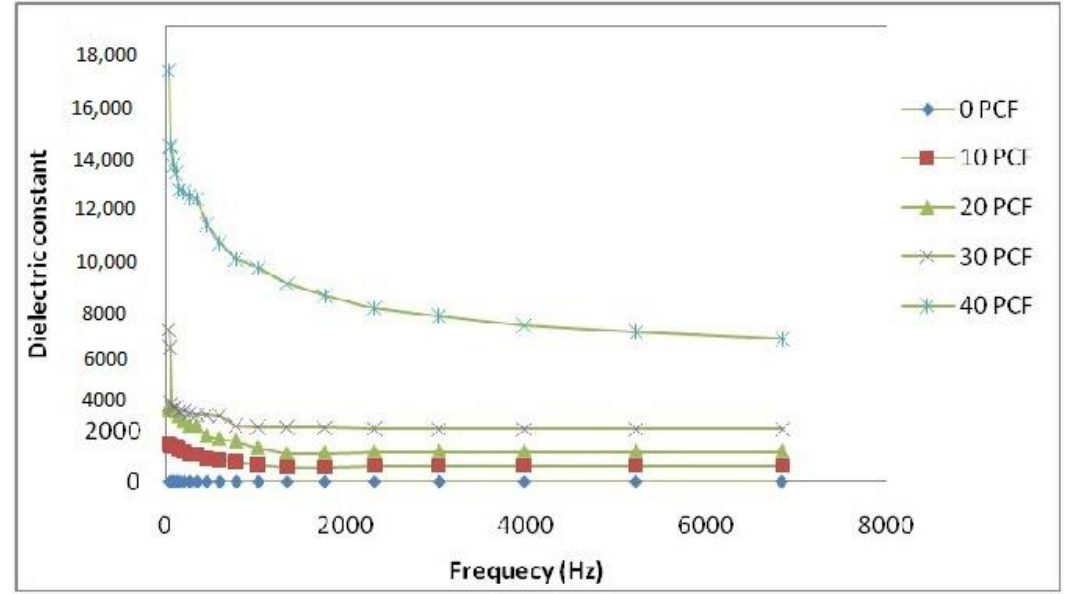
Figure 10. Variation in dielectric loss of HDPE-coated fiber/PE composites with frequency.